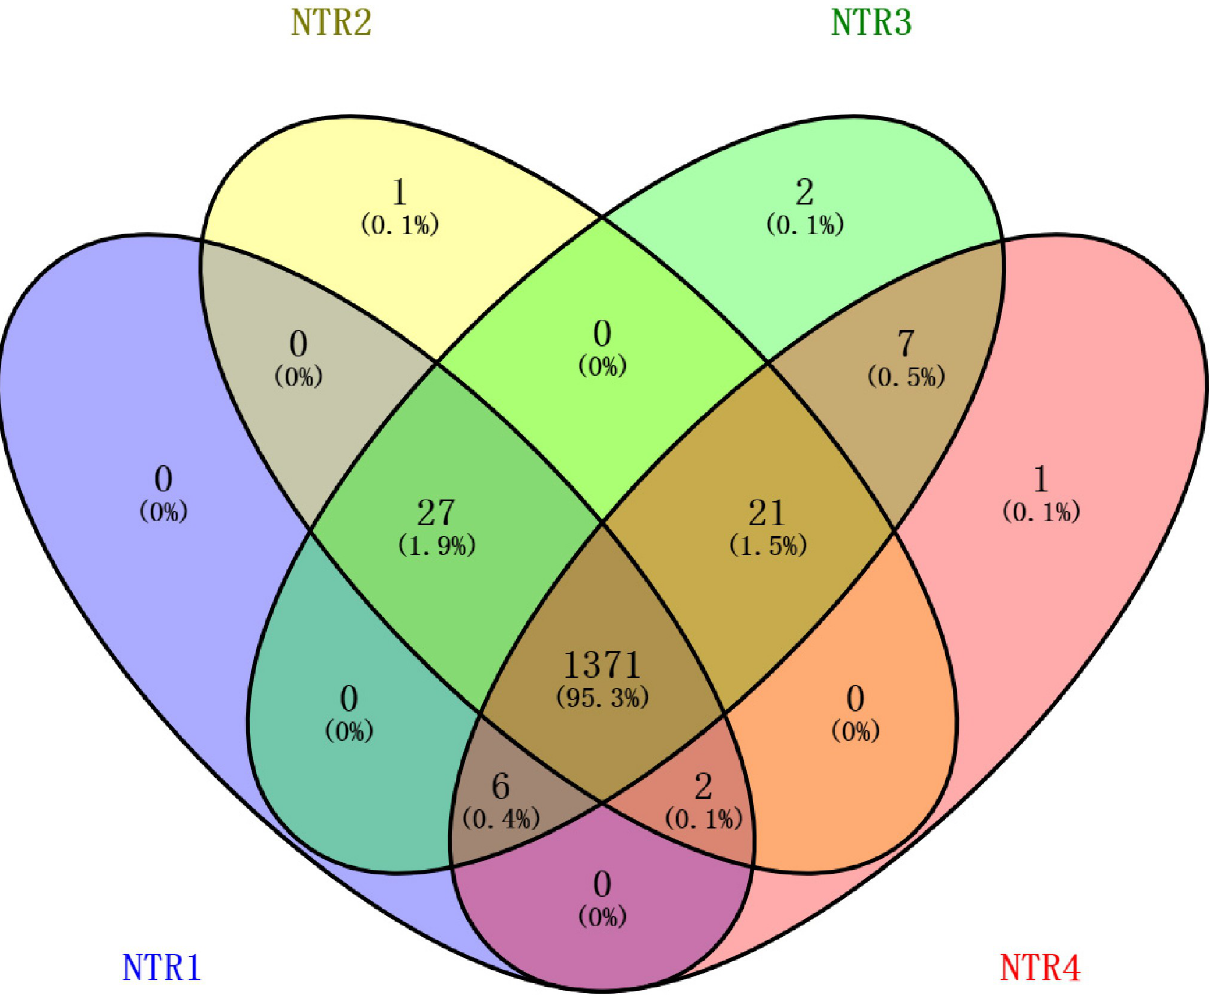
Fig 1. Venn diagrams showing the shared and unique OTUs after different no tillage and crop residue mulching treatments. NTR1, no tillage and all crop residue removed; NTR2, no tillage and 30% crop residue mulching; NTR3, no tillage and 60% crop residue mulching; NTR4, no tillage and all crop residue